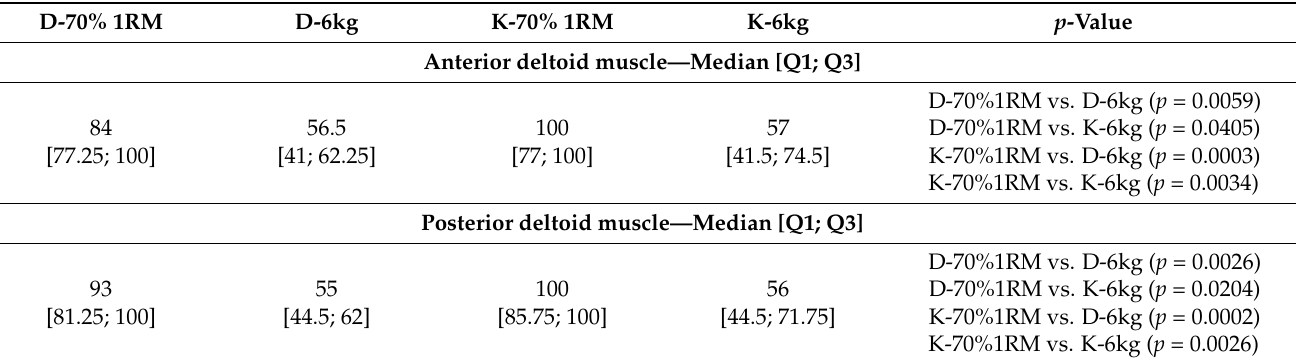
Table 2. Median, lower and upper quartile (Q1; Q3) of the maximum activity of the anterior part of muscle deltoid and posterior part of muscle deltoid, where: D-6kg—6 kg dumbbell press, K-6kg—6 kg kettlebell press, D-70% 1RM—70% of the 1RM dumbbell press, K-70% 1RM—70% of the 1RM kettlebell press. The p -values are for the Dunn Bonferroni post-hoc